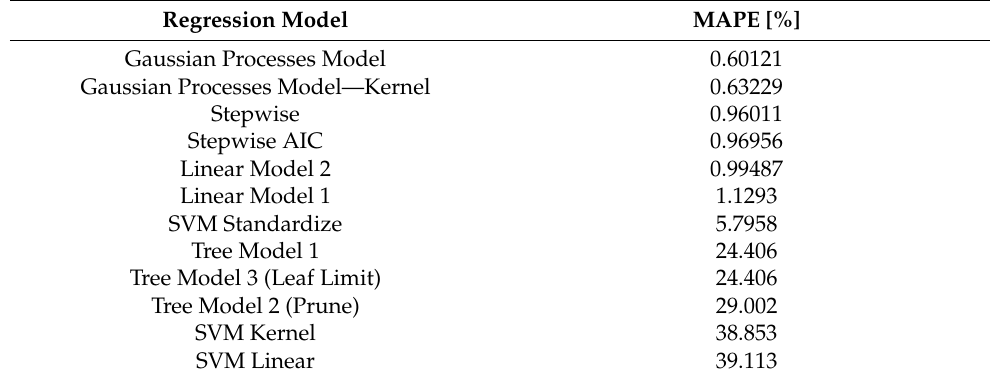
Table 5. Computational results for mdl in the operation system for the test object with BESS 2.